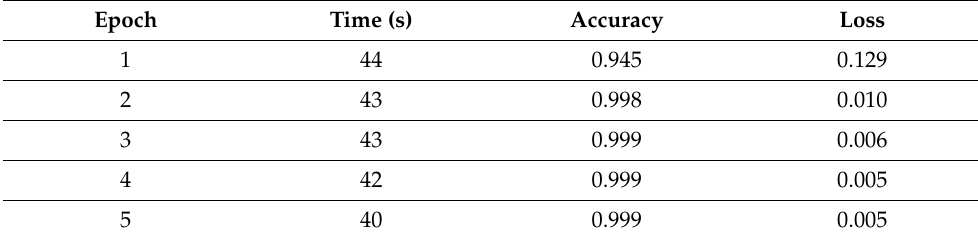
Table 7. Training dataset of 2 March 2018 with the feature set reduction through PCA.